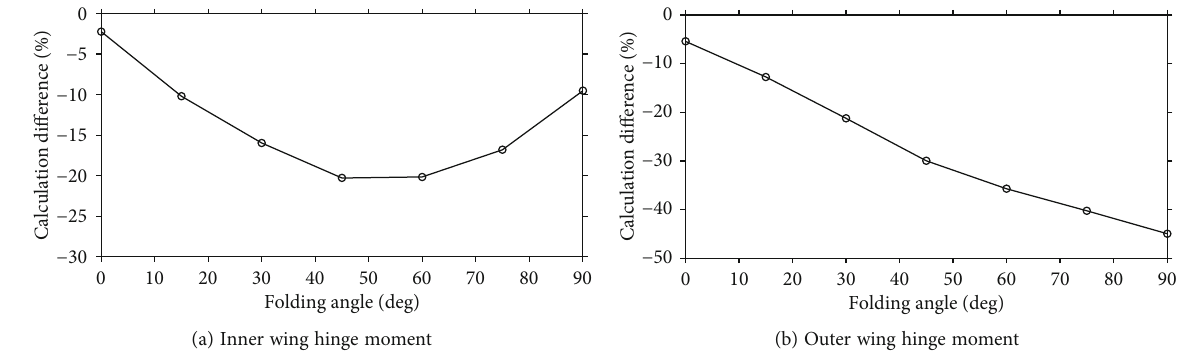
Figure 14: Calculation di ff erences of the hinge moments.